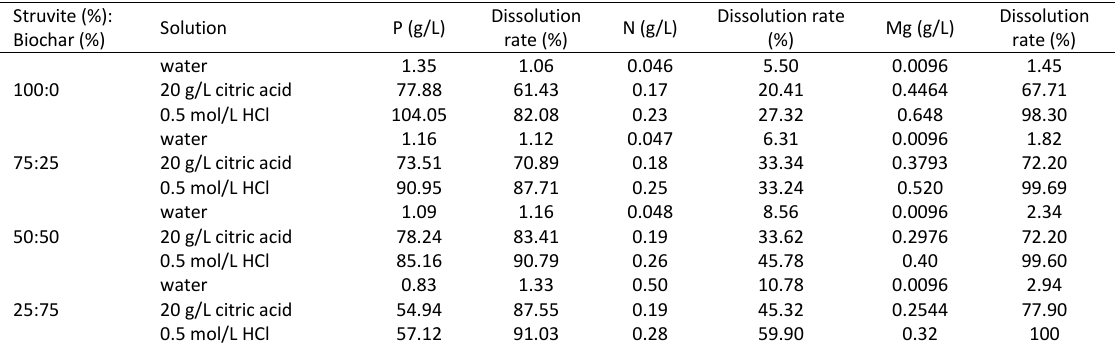
Table 7: Solubility of samples in water, citric acid, and HCl